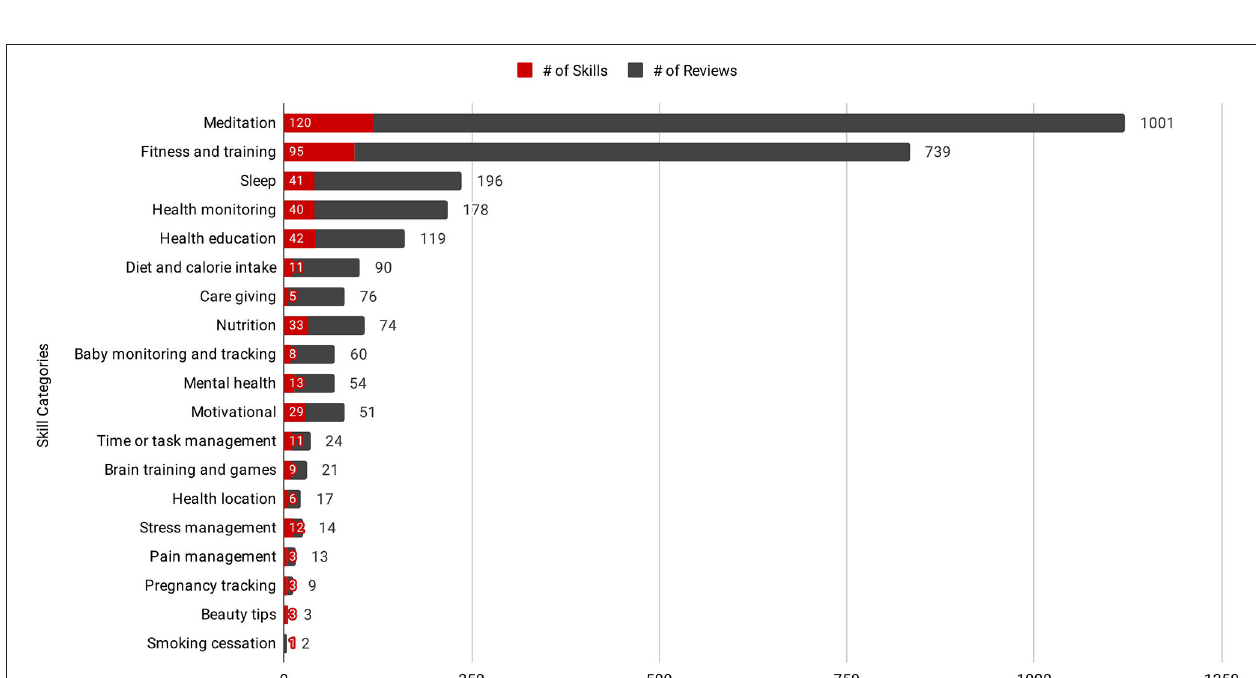
FIGURE 2 | Distribution of Skills and reviews for each of the 19 health and fitness categories included in this study.